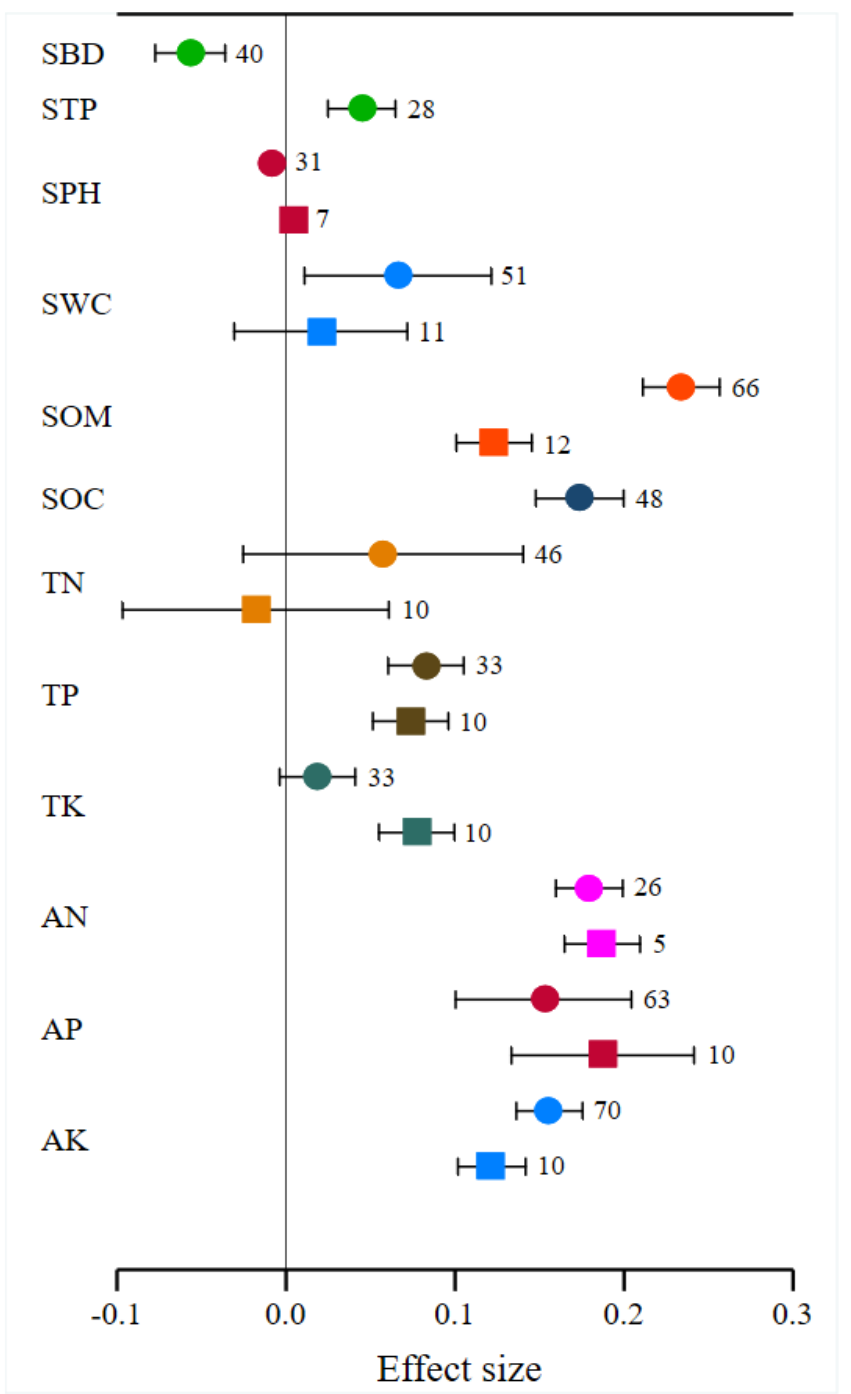
Figure 2. Effects of mulch methods on soil physicochemical properties of apple orchards in China. The circles and squares represent artificial grass and natural grass, respectively. Weighted means and their 95% confidence intervals of the effect sizes are given. The numbers on the right side of the confidence intervals represent the sample sizes. SBD: soil bulk density; STP: soil total porosity;